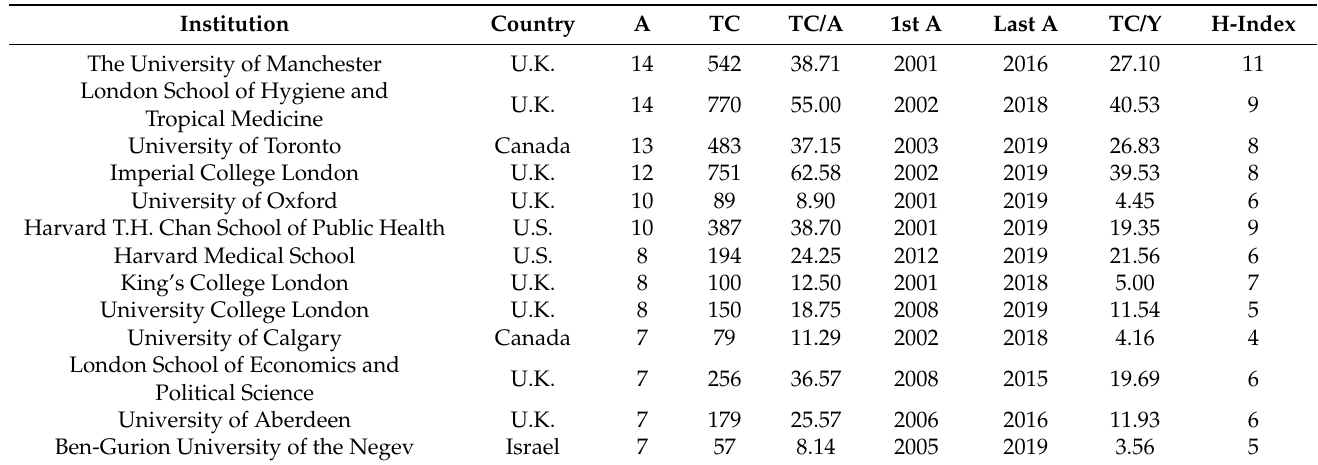
Table 6. The top 13 most productive institutions on PS and HP research.